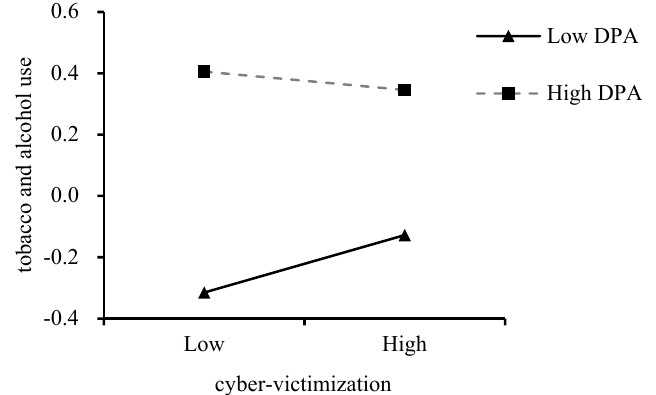
Figure 2. Moderating effect of deviant peer affiliation (DPA) on the relationship between cyber- victimization and tobacco and alcohol use among high school students. The solid black slope is significant ( p < 0.05), the dashed grey slope is not.